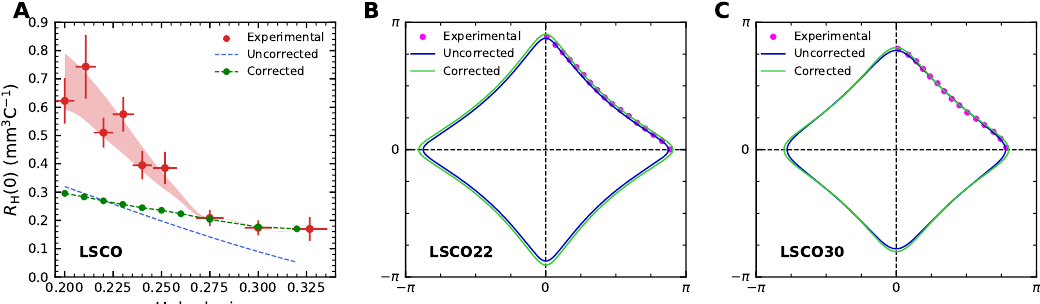
( 0 ) in OD LSCO. (Red circles) Figure 7: A) : Doping dependence of the low- T R H ( 0 ) values obtained from the literature (see Table 8 and text Binned and averaged R H for details of how these were obtained). The red shaded area provides an indication of the spread in the (binned and averaged) experimental values. The blue line is ( 0 ) estimated from Boltzmann transport theory using the TB pa- the evolution of R H rameterization of the (full) FS and assuming a scattering rate 1 / τ ( φ ) with the same ( φ ) . The green circles are the values of in-plane anisotropy as the ARPES-derived v F ( 0 ) calculated again assuming a fully coherent FS but now with a correction to R H satisfy the Luttinger count and adjust the FS curvature accordingly (but still remain consistent with the ARPES measurements to within their experimental momentum resolution). The green dashed line is an interpolation between these points. Note = 0.27. Er- the bifurcation of the red symbols and the green dashed line at p = p SC ( 0 ) values are obtained from the standard deviation ror bars for the experimental R H of the binned literature values coupled with an estimated 10% uncertainty in the determination of the sample thicknesses. B) : Comparison between the uncorrected (blue) and corrected (green) Fermi surfaces for p = 0.22 compared with the locus (solid fuchsia circles) of the ARPES-derived FS from Yoshida et al. [ 40 ] . C) : Same comparison for p = 0.30. In both cases, the change in curvature matches well with ( 0 ) values are found the ARPES FS; for p = 0.30, the corrected and as-measured R H to